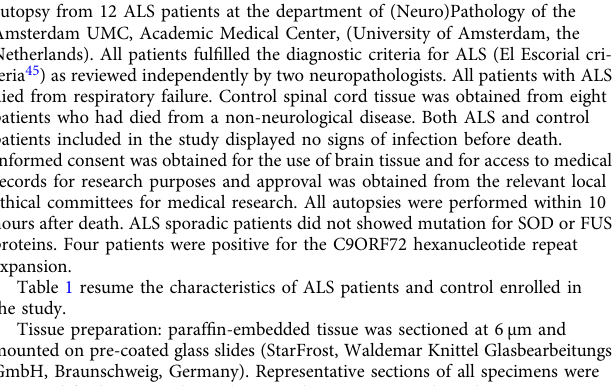
Table 1 resume the characteristics of ALS patients and control enrolled in the study. Tissue preparation: paraf fi n-embedded tissue was sectioned at 6 µm and mounted on pre-coated glass slides (StarFrost, Waldemar Knittel Glasbearbeitungs GmbH, Braunschweig, Germany). Representative sections of all specimens were processed for haematoxylin and eosin, Klüver-Barrera and Nissl stains.